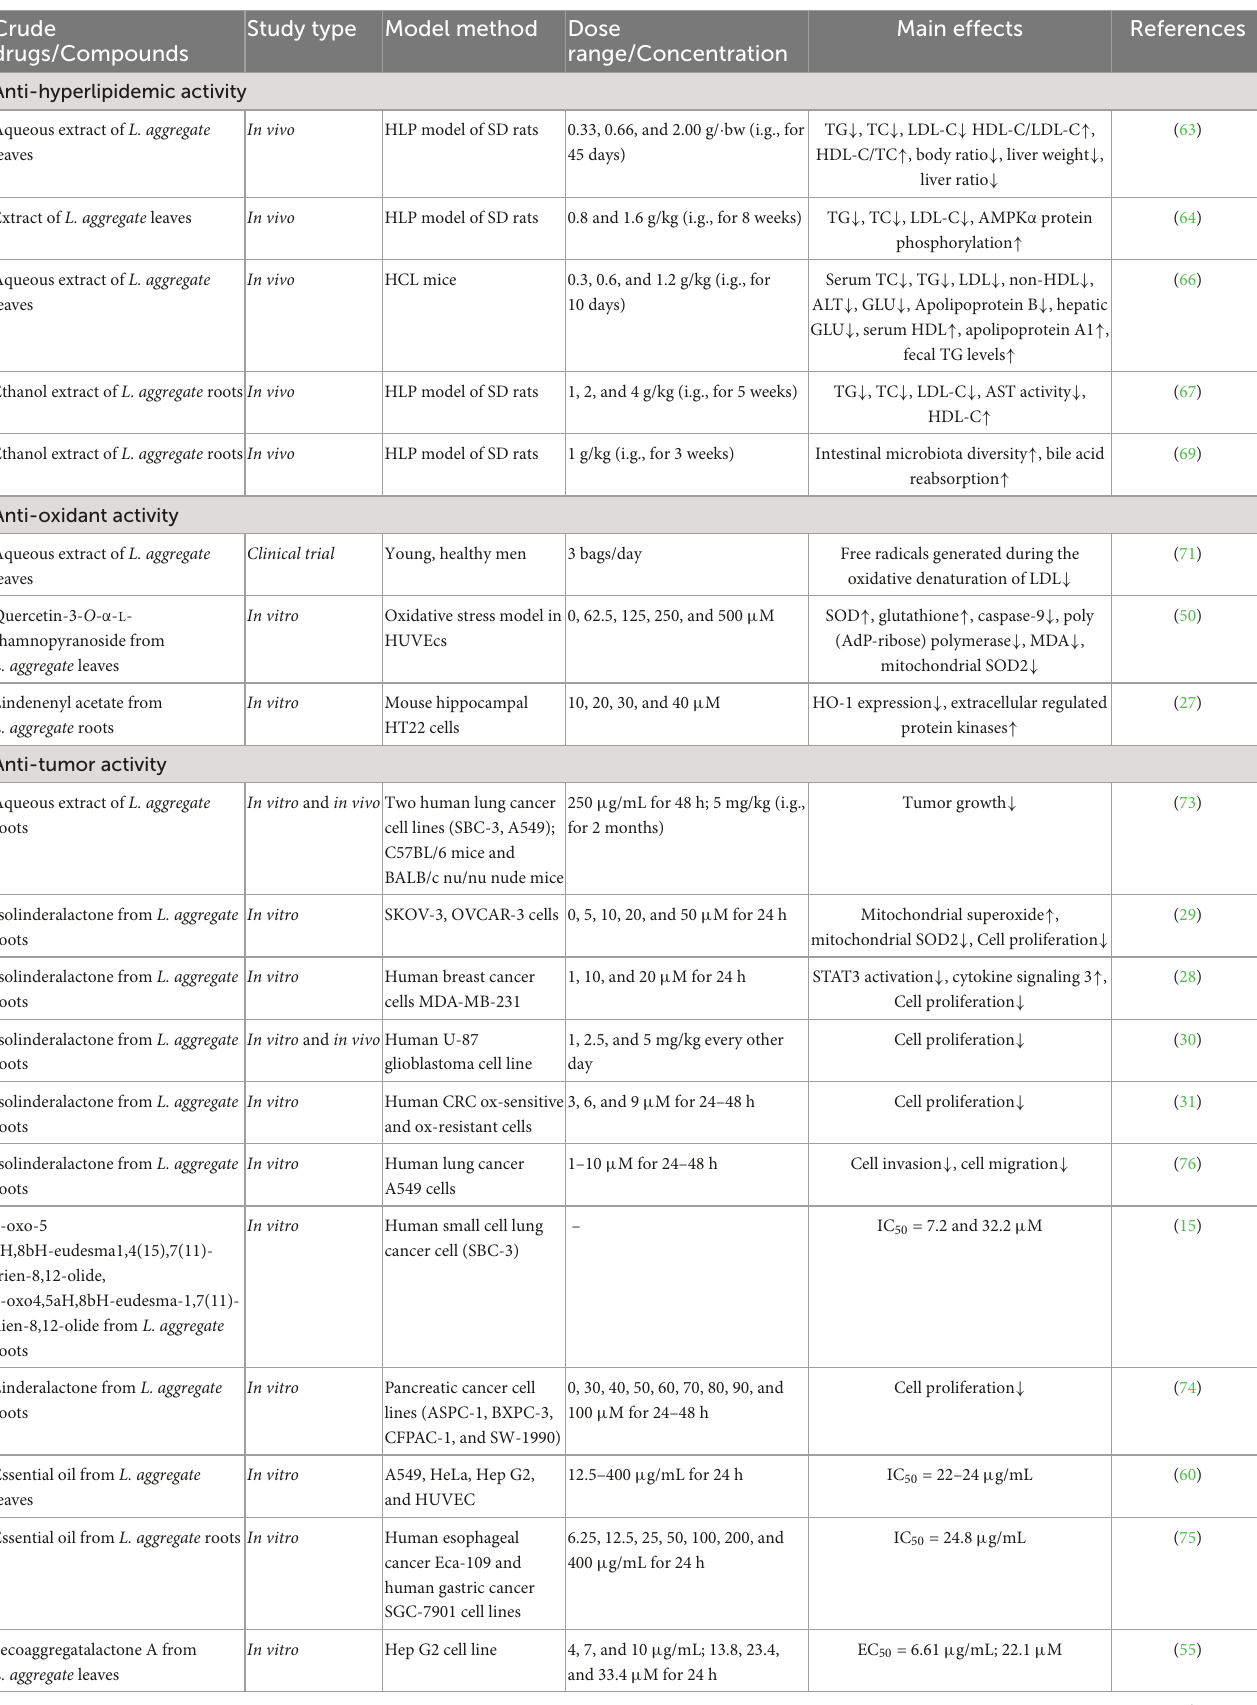
TABLE 5 Pharmacological activities of different parts of L. aggregata . Crude